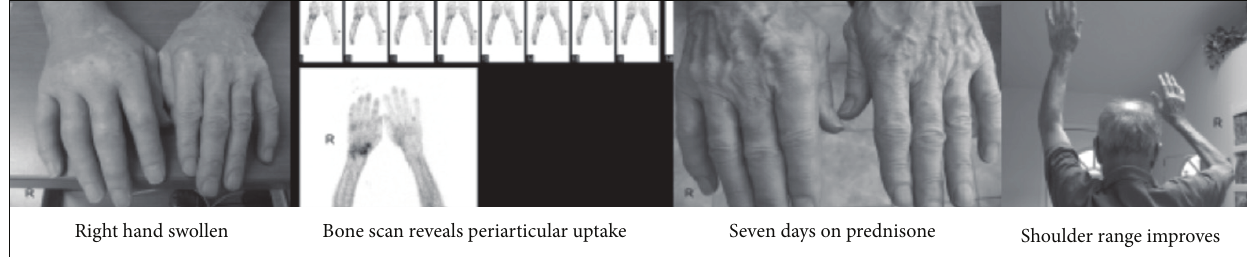
Figure 1: Case 1 : a 78-year-old man with a central cord syndrome due to a flexion extension injury causing disc herniation and cord compression. After surgery, he regained the ability to walk with slow improvement of arm function. Four months later, he developed painful swelling of the right hand and loss of range in the denervated right shoulder, with loss of use of the right